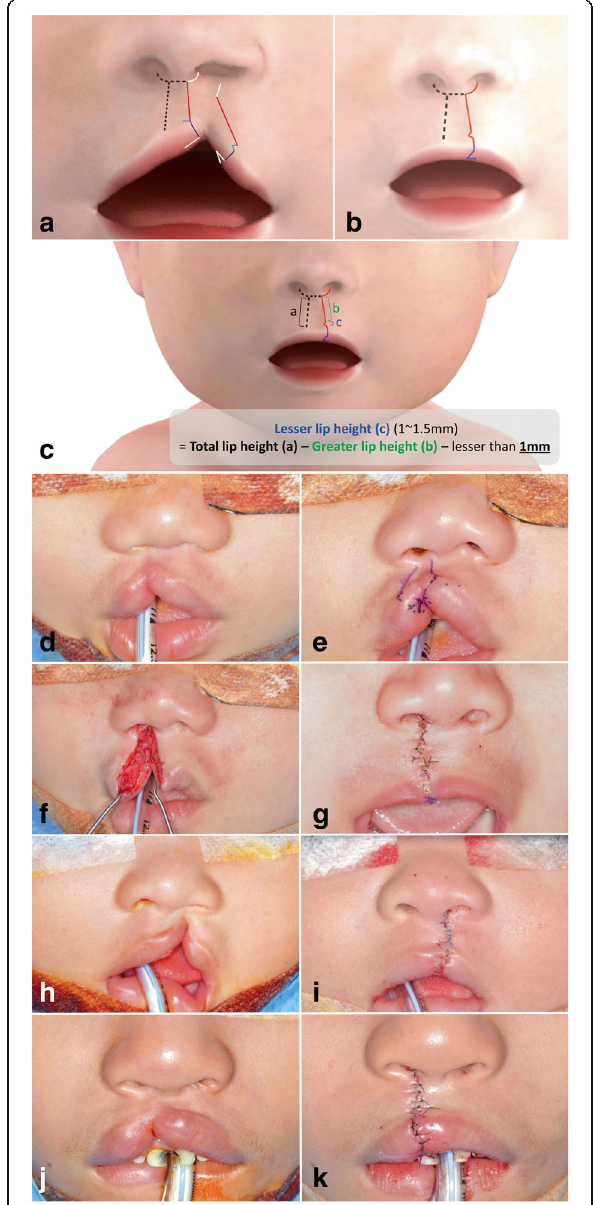
Fig. 1 Incomplete unilateral cleft lip. a Surgical design: dotted line represents noncleft side normal anatomical landmarks. Circumferential incision along the columella and philtral ridge should be symmetric to the normal side. Each length of incision lines with same color is equal. Inlet incision on medial flap of cleft margin ( blue line ) has same length with each side of small triangle. This small triangle should be just above the cutaneous roll, and if there is enough length in lateral flap of cleft side, then small triangle flap might be omitted. b After approximation, scar line on the philtral ridge of cleft side is less visible than other methods. c Cleft side lateral lip element can be lengthened by small triangular flap and Rose-Thompson effect. Therefore, the length of the lesser lip height, which means the base of the small triangle, should be 1 mm less than the greater lip height. d-g Nine-month-old boy with incomplete unilateral cleft lip (case 1). h , i Six-month-old boy with incomplete unilateral cleft lip (case 2). j , k Five-year-old boy with incomplete unilateral cleft lip (case